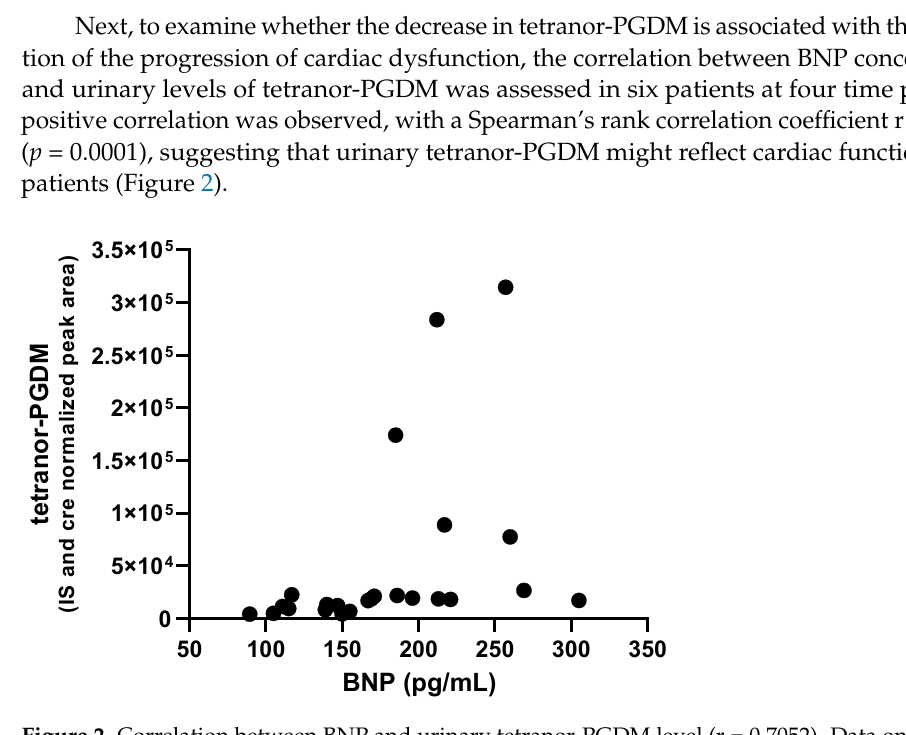
Figure 1. Alteration of urinary tetranor-PGDM level in MD patients between pre- and post-administration of tranilast. Fold-changes were calculated as ratios of levels at 4, 12, and 24 weeks relative to 0 weeks for each patient. Data were represented as medians with interquartile ranges of N = 6. p -values were determined using the Dunn’s post-hoc analysis.